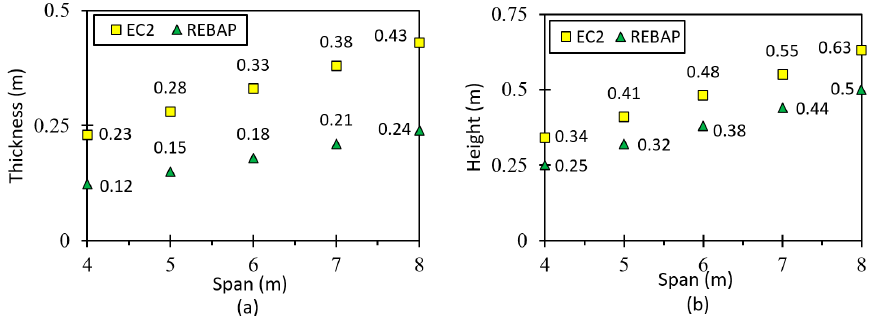
Figure 1. ( a ) Minimum thickness of the simply supported slab and ( b ) minimum height of the sup- ported beam. supported